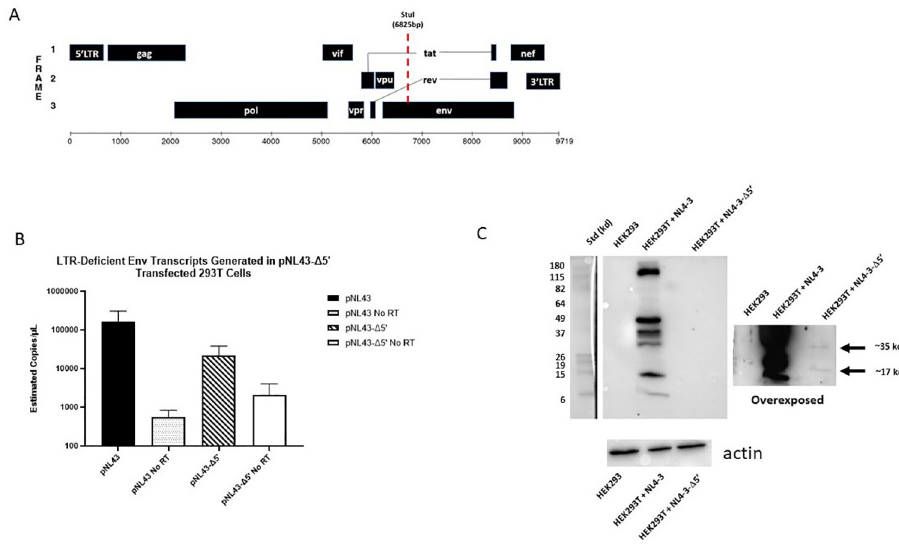
Fig 6. Truncated HIV-1 proviral construct expresses RNA and protein. (A) Schematic of HIV-1 NL4-3 in pNL4-3 expression plasmid and location of StuI -restriction digest site used to generate pNL4-3 Δ 5’ (bottom). (B) RT-ddPCR data from HEK-293T cells transfected with either full length pNL4-3 (black) or pNL4-3 Δ 5’ (striped) for 24-hours. RNA samples were subjected to multiplex ddPCR using a probe for the 5’LTR and a probe for env and droplets were quantified as indicated above. Reaction mixtures without RT enzyme (No RT) were used as negative controls for contaminating plasmid DNA. No LTR signal was detected for HEK293T cells transfected with pNL4-3 Δ 5’. Data include 4 independent pNL4-3 transfections and three pNL4-3 Δ 5’ transfections. (C) Western blots using cell lysate from HEK293T cells transfected with either full length pNL4-3 plasmid or pNL4-3 Δ 5’. Lysates were run on 12% SDS-PAGE gel, transferred to a PDVF membrane, and probed with human polyclonal anti-HIV IgG. Two exposures are shown: a short exposure demonstrating HIV-1 proteins (left) and an extended exposure which shows weaker HIV protein bands at approximately 35 kDa and 19 kDa, as indicated by the arrows (right). Non-transfected HEK293T cell lysates were also probed as a negative control. The lower panel is a separate gel from the above lysates probed with a monoclonal against β -actin antibody demonstrating the presence of proteins in the different